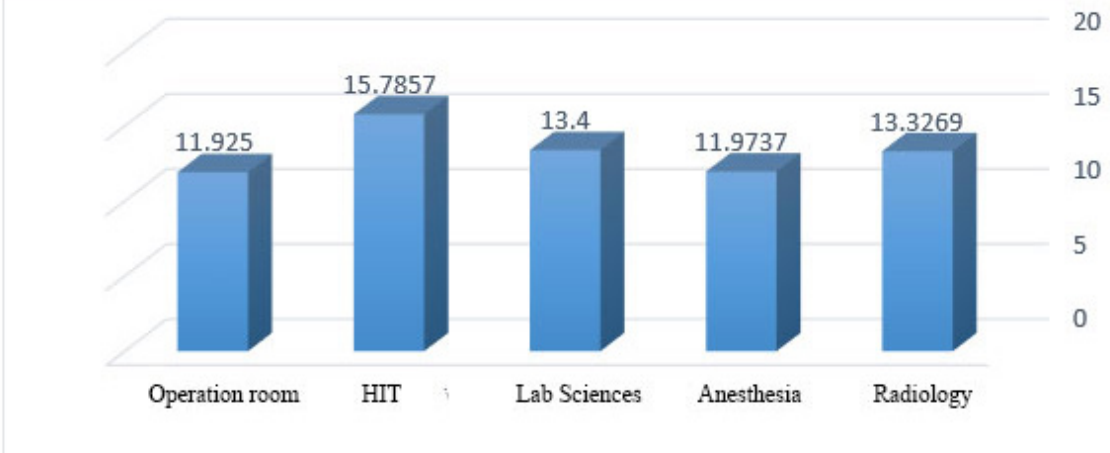
Figure 1: Mean information literacy score regarding different domains of